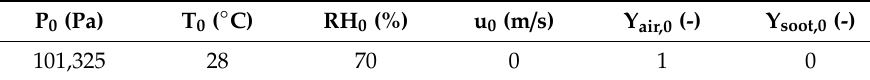
Table 1. Initial condition for the problem under study.